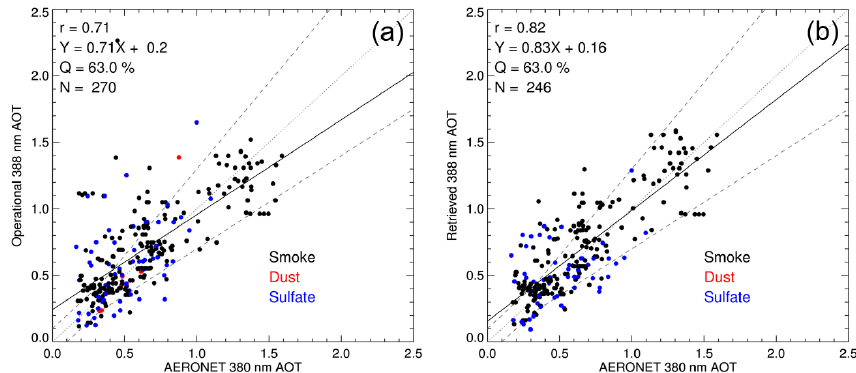
Figure 6. Validation of 388nm AOT against AERONET data from (a) operational products and (b) the OE-based algorithm during the DRAGON-NE Asia 2012 campaign.